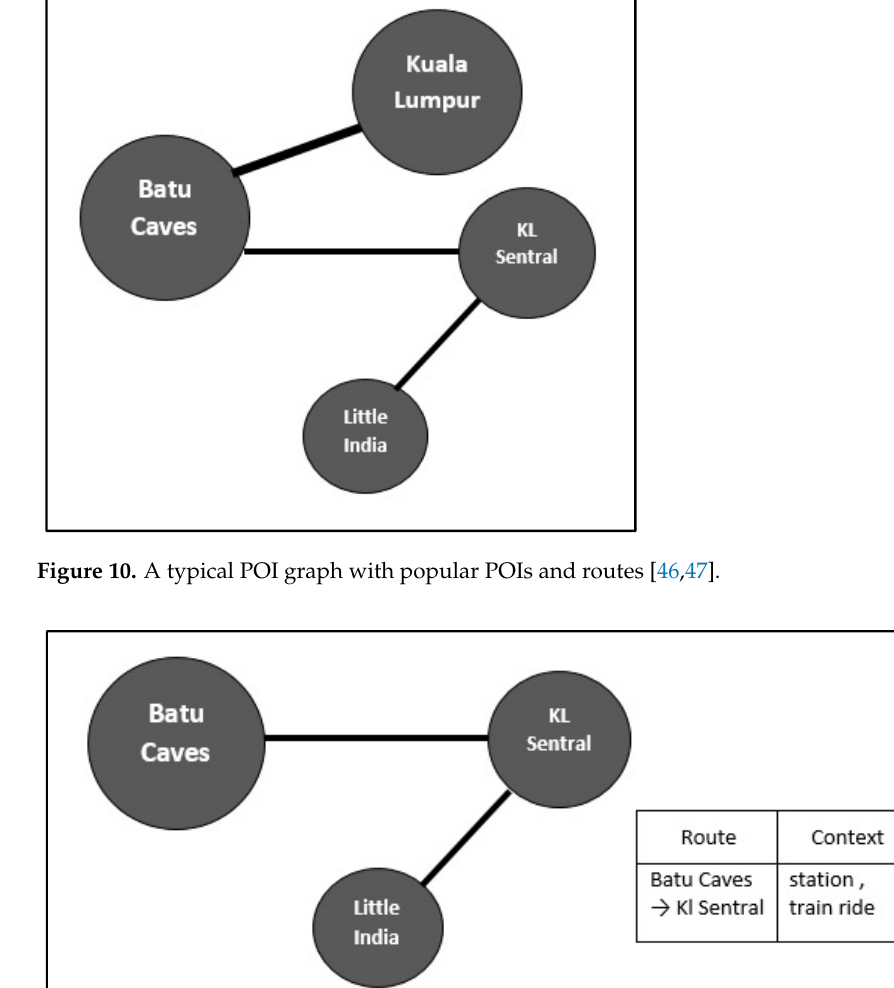
Figure 12. A POI graph of geographically close locations with local features [20]. Table 10. Comparison between the proposed and existing POI graph representations. Graph Representation